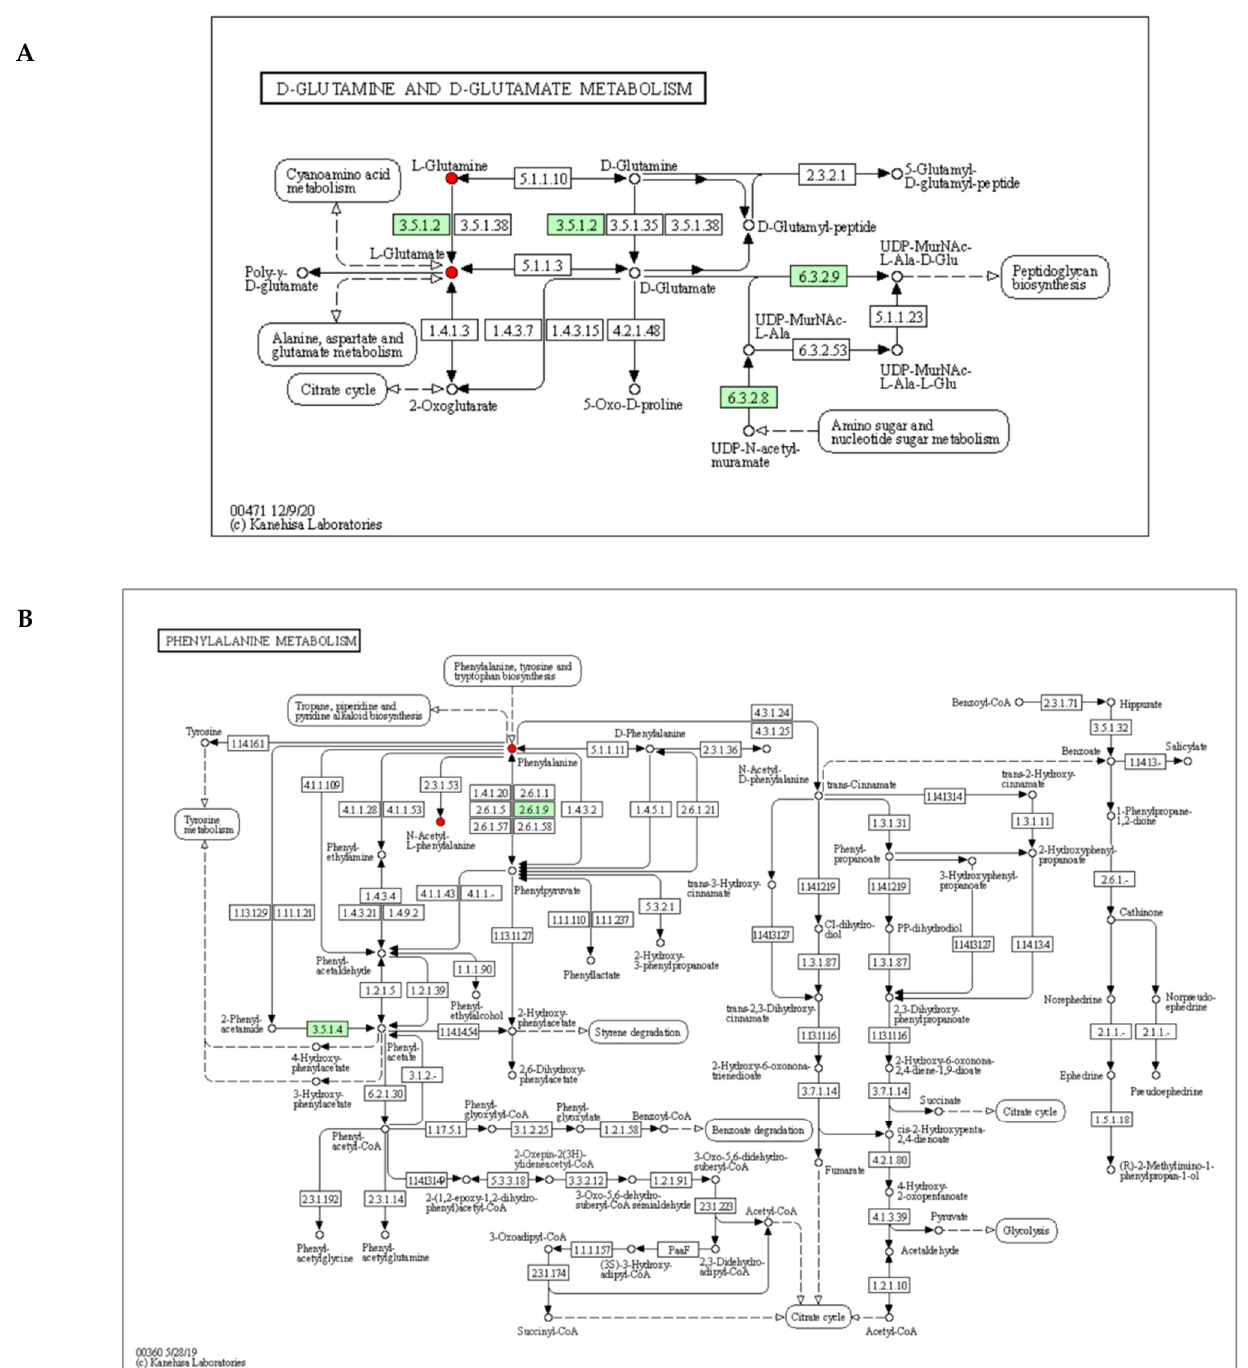
Figure 8. KEGG pathway analysis of differential metabolites. (A) D-glutamine and D-glutamate metabolism pathway of M1 vs. S1, ( B ) phenylalanine metabolism pathway of M40 vs. S40. Abbreviations: M, mixed-fermentation cheese; S, single-strain-fermentation cheese. Numbers 1–40 represent different ripening times (in days).